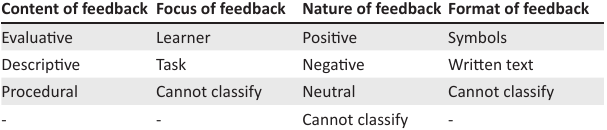
TABLE 2: Typology applied for analysing teachers’ written feedback. Content of feedback Focus of feedback Nature of feedback Format of feedback